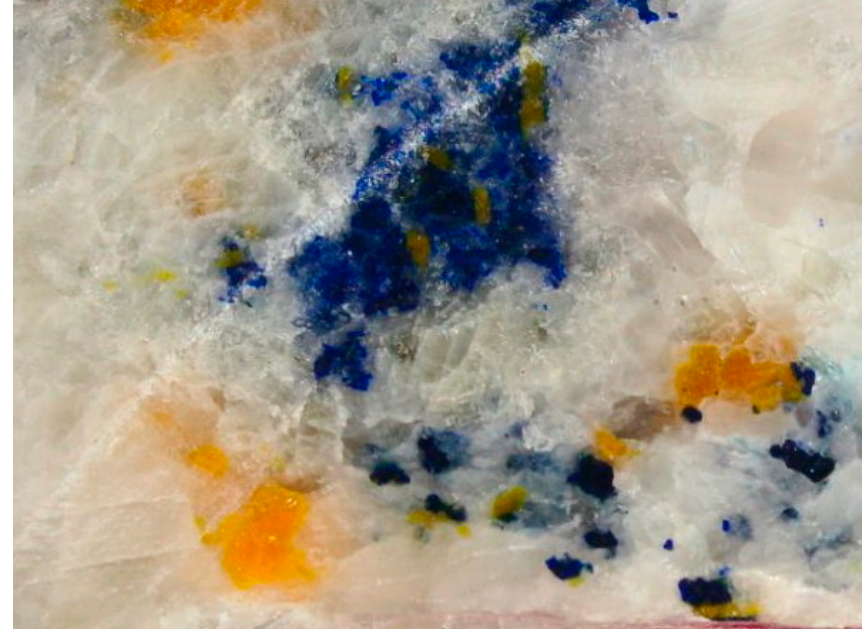
Figure 4. Grains of lazurite (dark blue, the ZK sample) in association with bystrite, ideally Na 7 Ca(Al 6 Si 6 O 24 )S 52 − Cl (orange–yellow) and diopside (light gray) in calciphyre. Field of view width: 22 mm. Photographer: Tatiana A. Radomskaya.